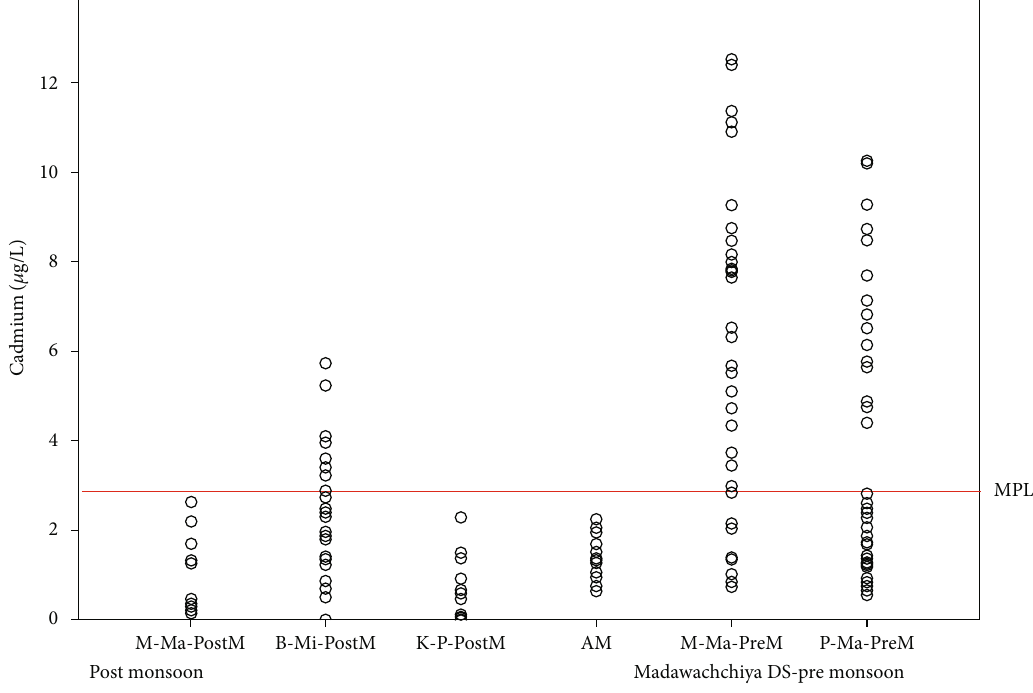
Figure 4: Cadmium content of well water samples in the study area.